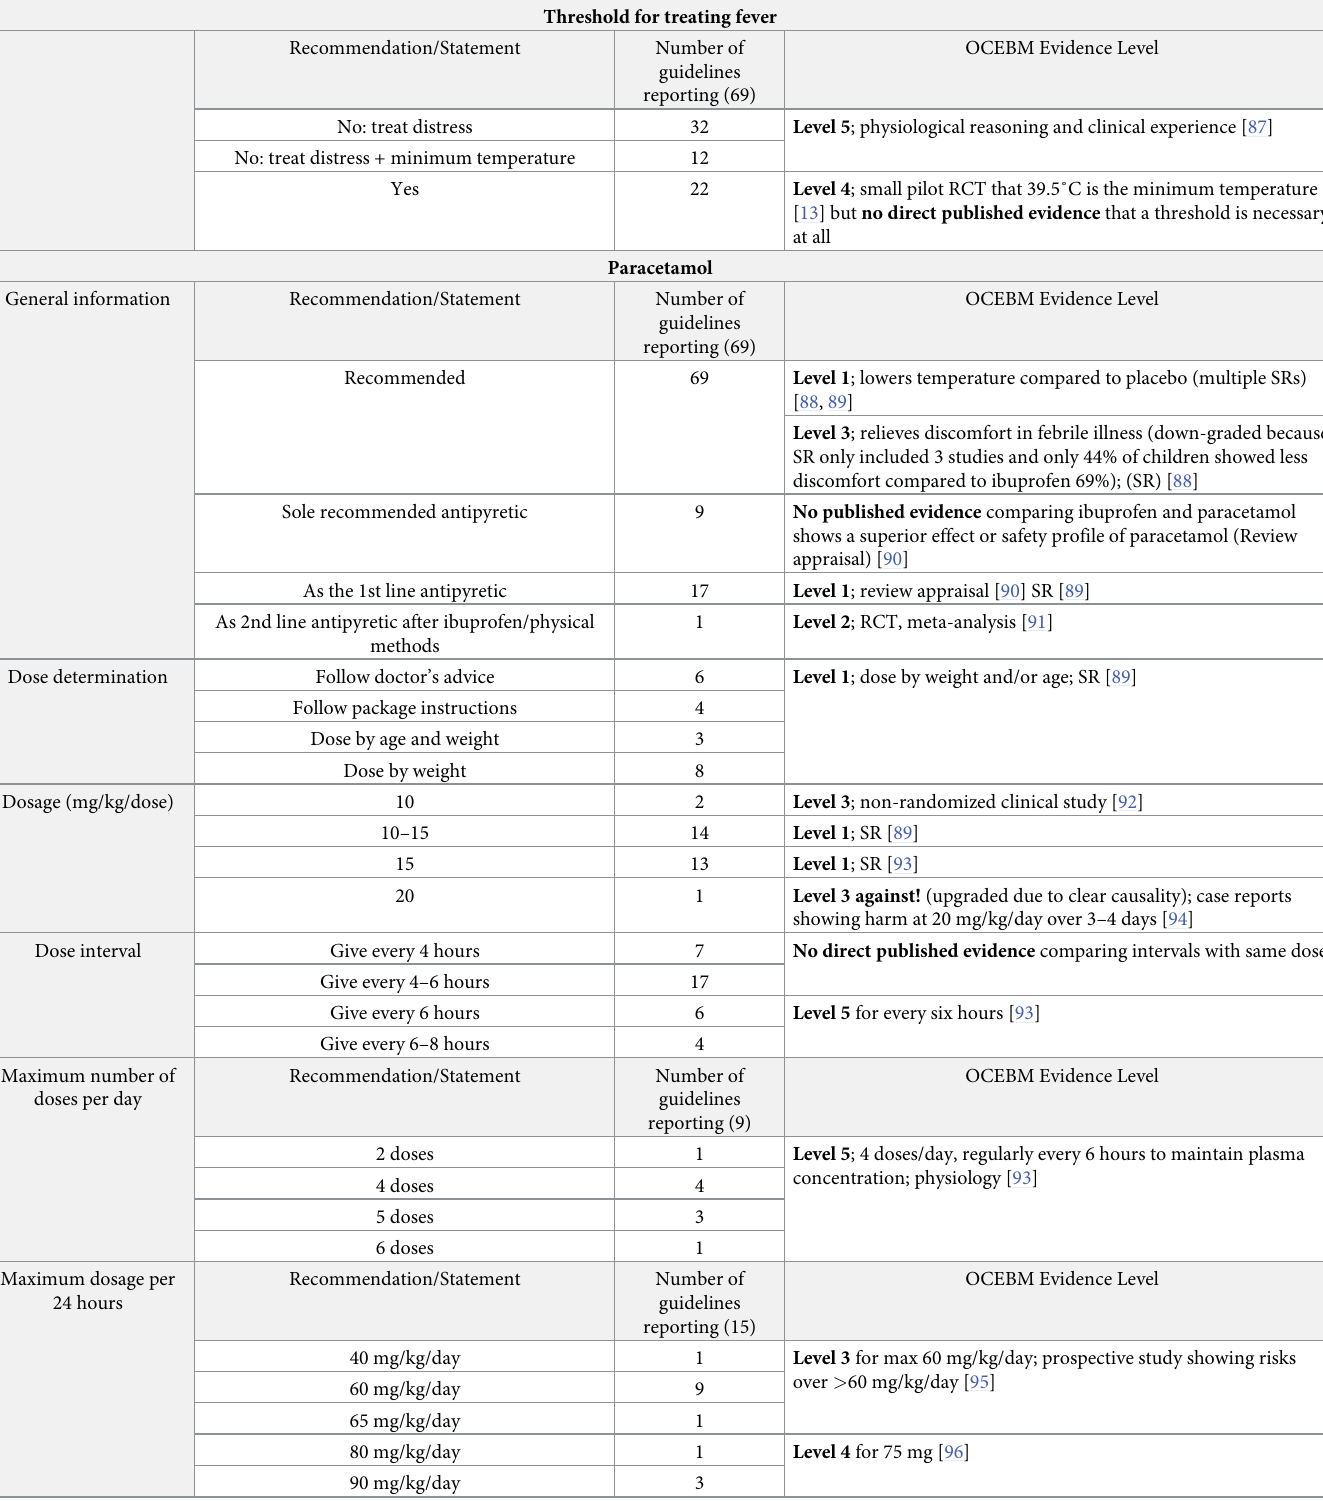
Table 1. Recommendations and evidence